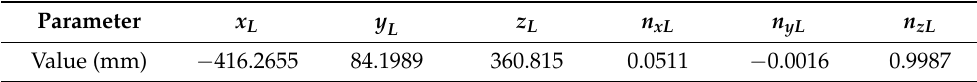
Table 5. Calibrated extrinsic parameters from LRF ( LCS ) to BCS